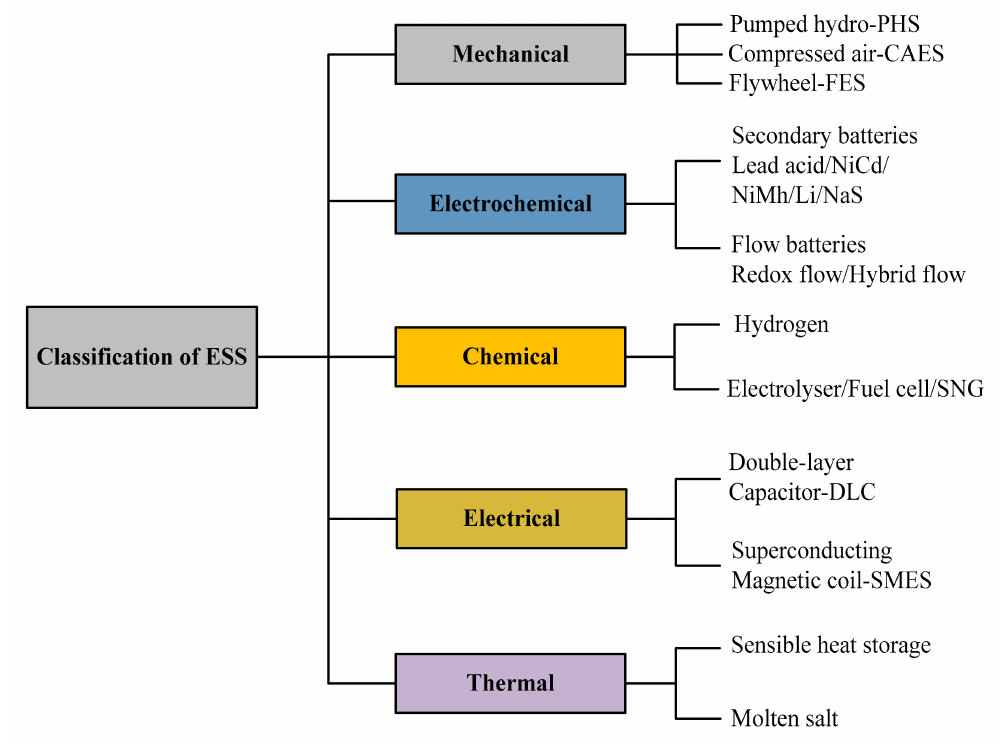
Figure 3. Classification of energy storage